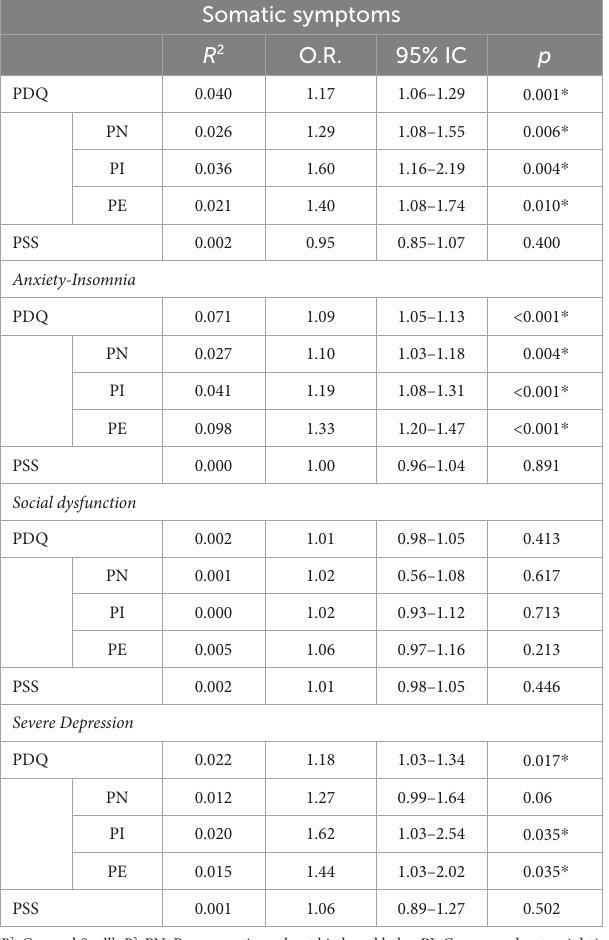
TABLE 6 Logistic regression analysis between general health and prenatal distress. Somatic symptoms